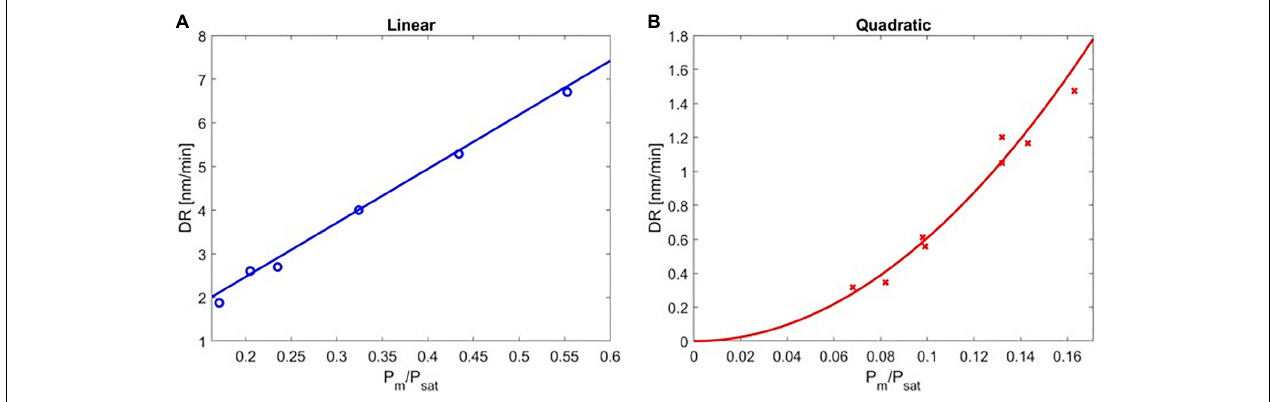
FIGURE 3 | The deposition rate of poly(4-aminostyrene) as a function of P m /P sat in the (A) linear, and (B) quadratic regimes.